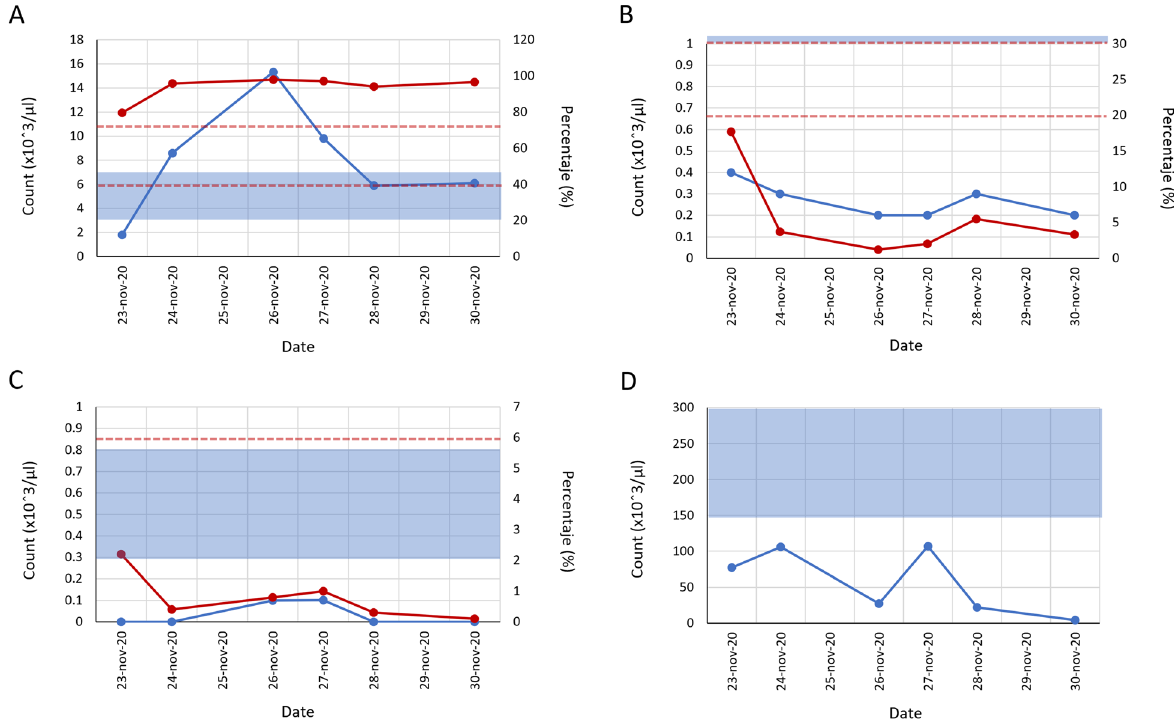
Fig. 1 Blood count tests. The graphs of different measurements of blood cells during the time of hospitalization of the patient are shown. A neutrophils, B lymphocytes, C monocytes, and D platelets. Cell number (blue line) and percentage (red line) values are shown; the solid blue bar and the interval between the red dotted lines represent the reference values for cell count and percentage,